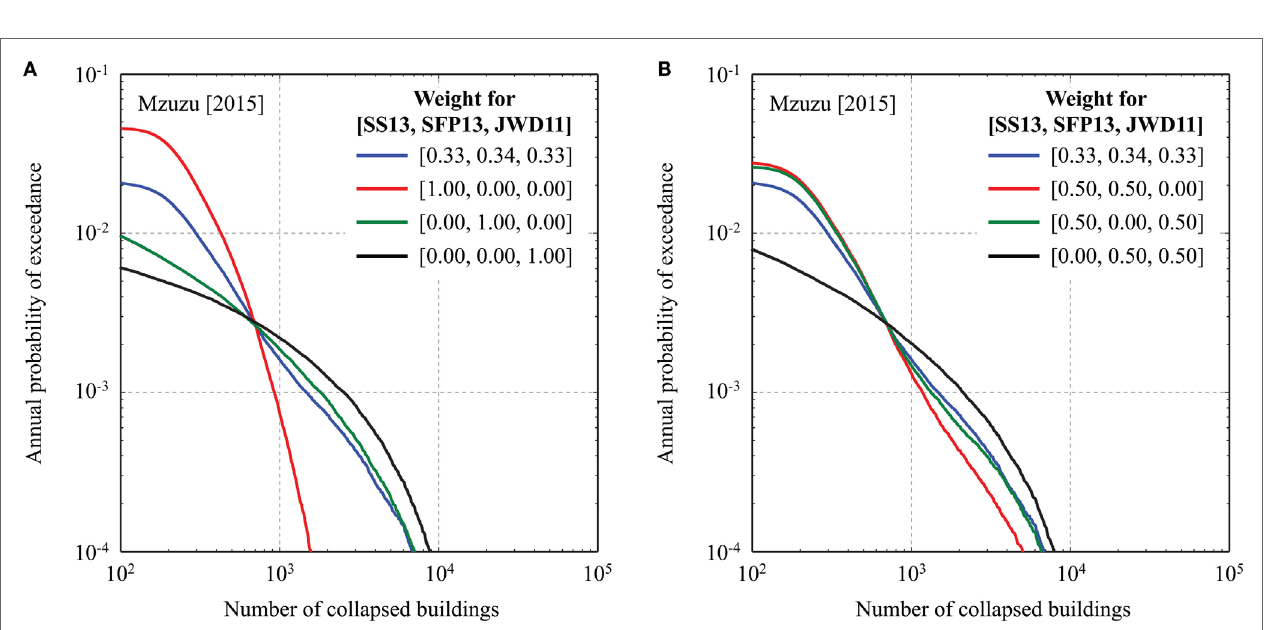
FigUre 13 | (a) Effects of exposure data (year 2010, 2015, and 2020) on affected population curves (MMI > 6.5) for Mzuzu. (B) Effects of exposure data (year 2010, 2015, and 2020) on building-collapse curves for